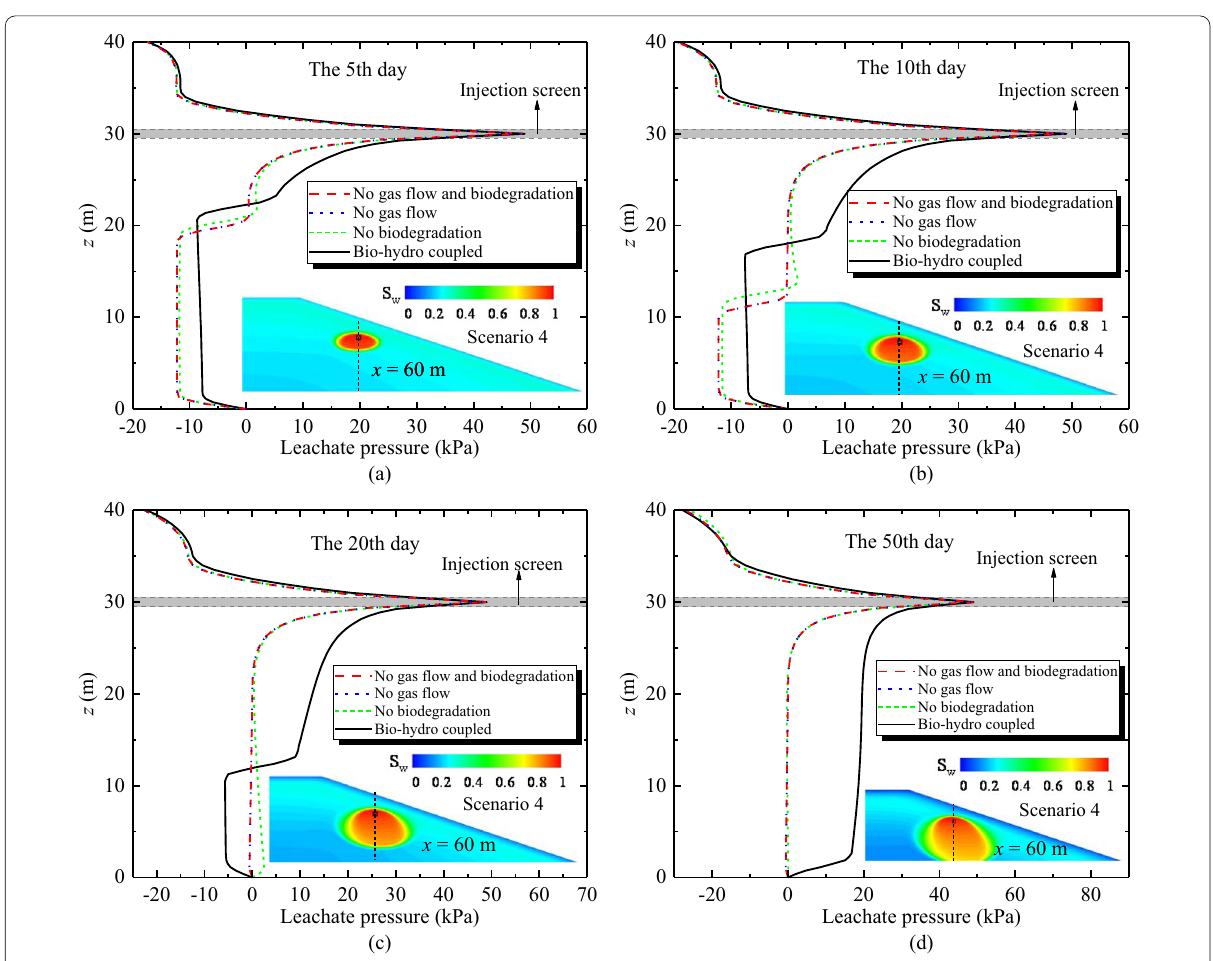
Fig. 5 Leachate pressure profiles at x 60 m of different scenarios on the: a 5th day; b 10th day; c 20th day; d 50th =